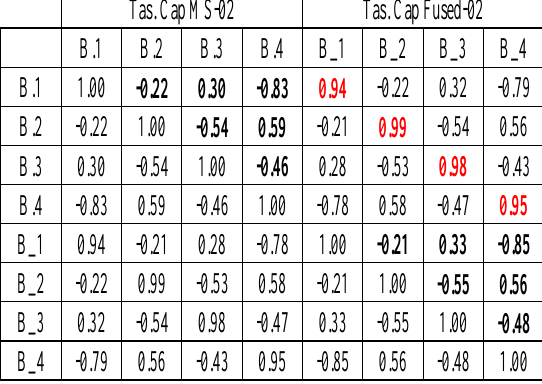
Table 9. Correlation matrix between the bands (B) of Tasselled Cap